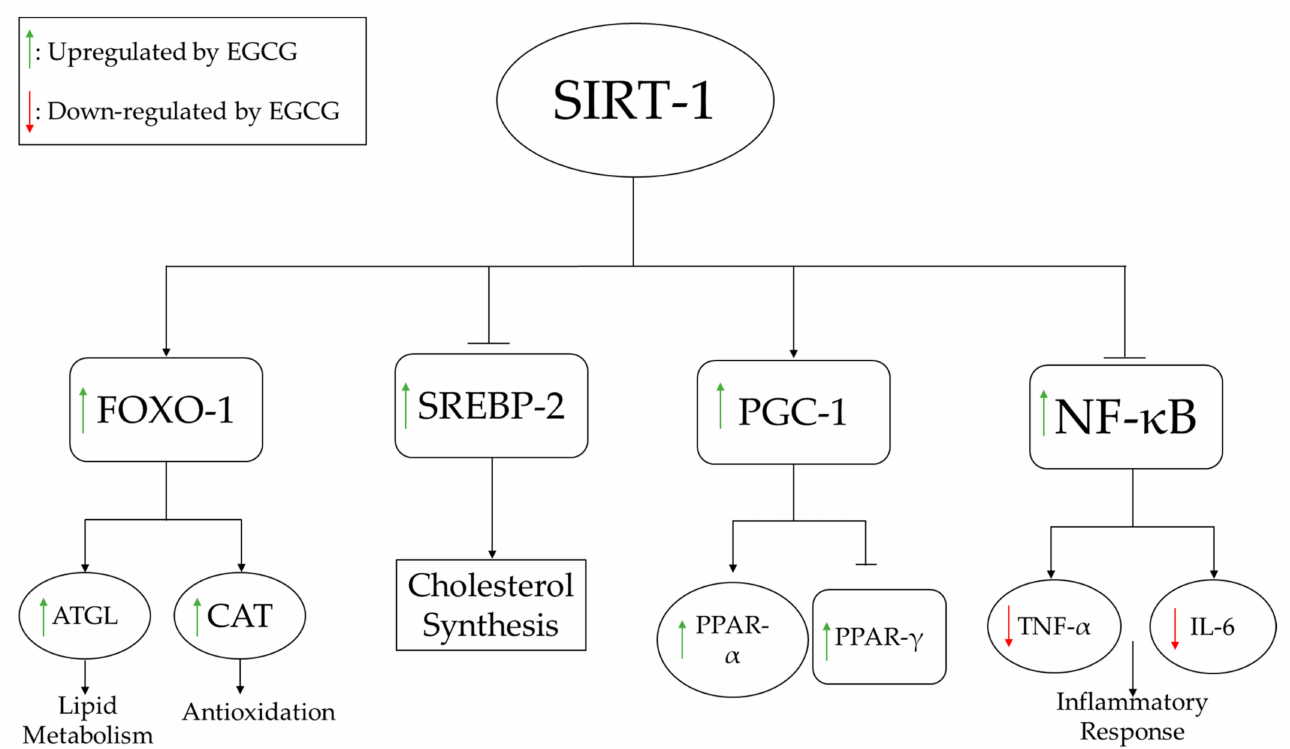
Figure 3. EGCG-induced SIRT-1 modulation of lipid metabolism, antioxidant pathways, inhi- bition of fatty acid synthesis, and inflammatory response pathways. ATGL increases lipoly- sis of fats, while increased CAT boosts the antioxidant status. NF-kB regulates several pro- inflammatory pathways, including the production of inflammatory cytokines such as IL-6